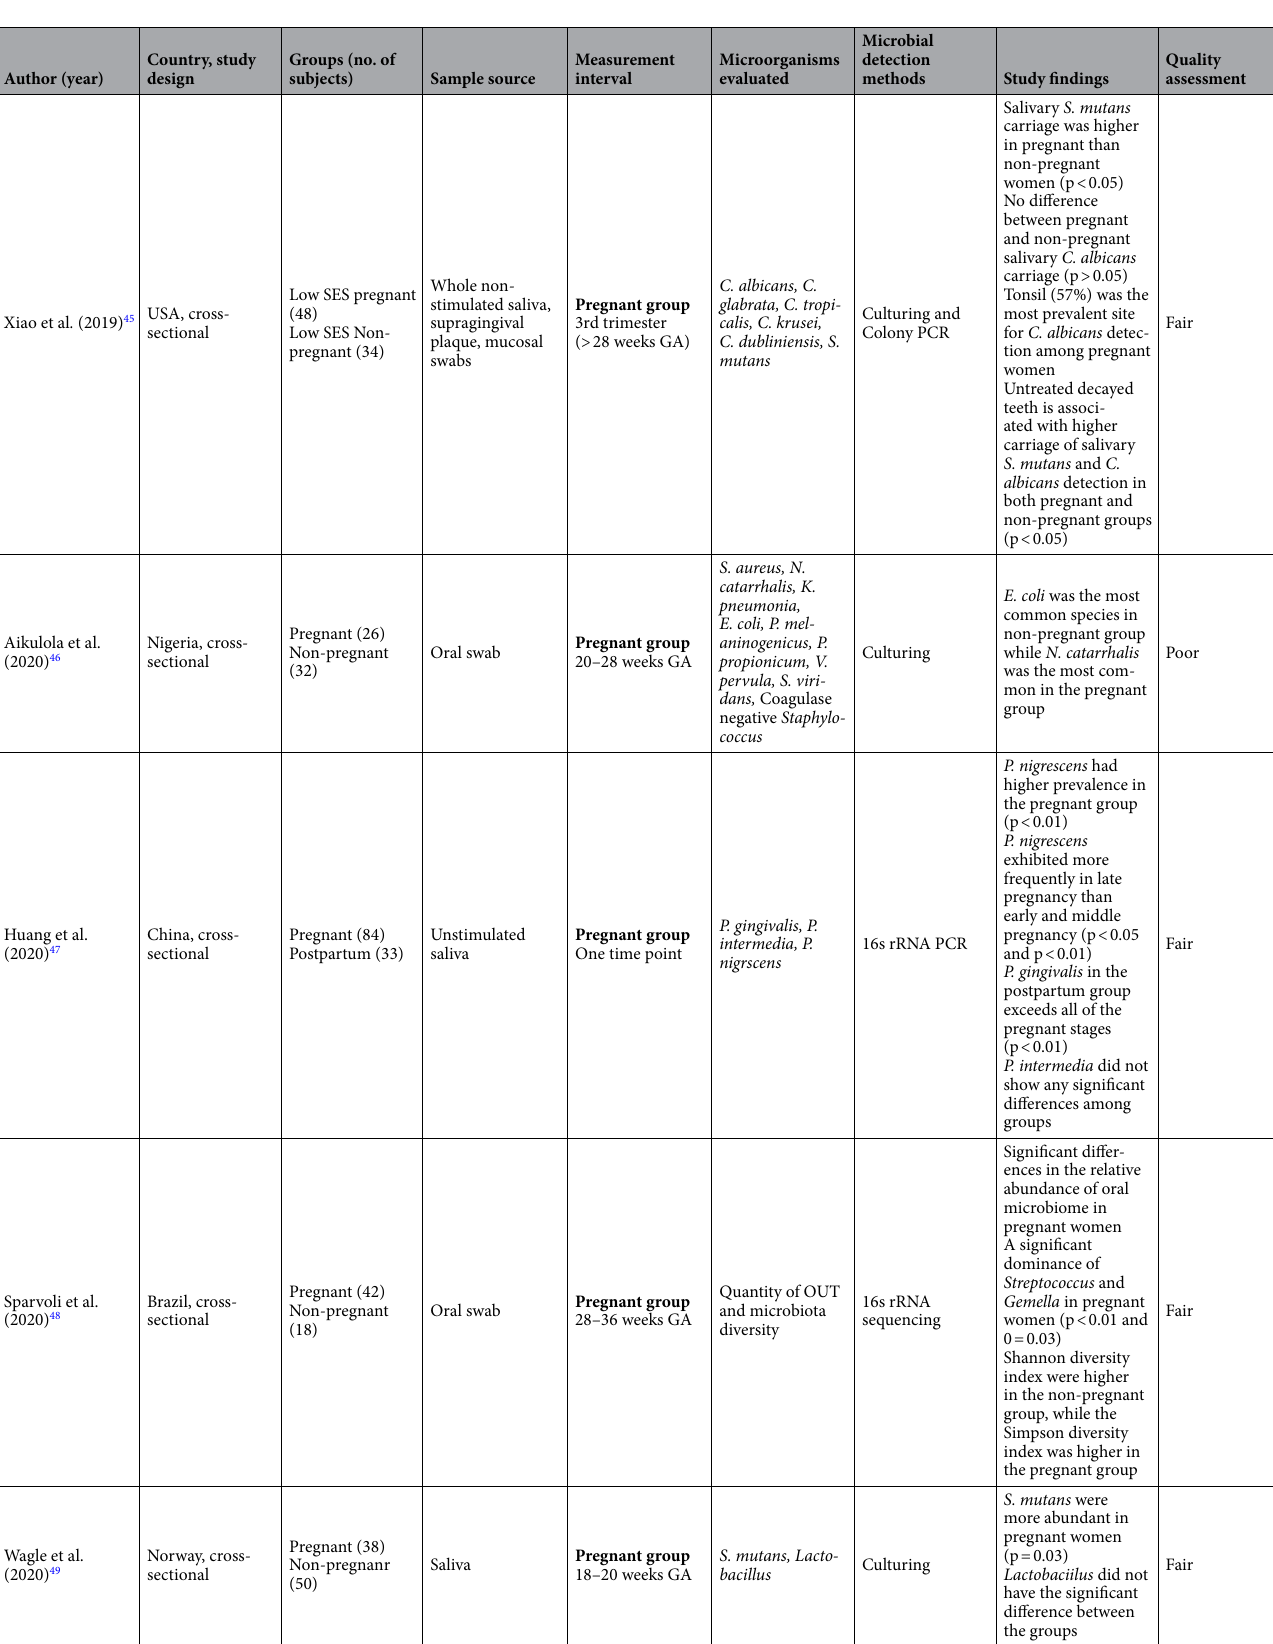
Table 1. Oral microbial differences between pregnant and non-pregnant